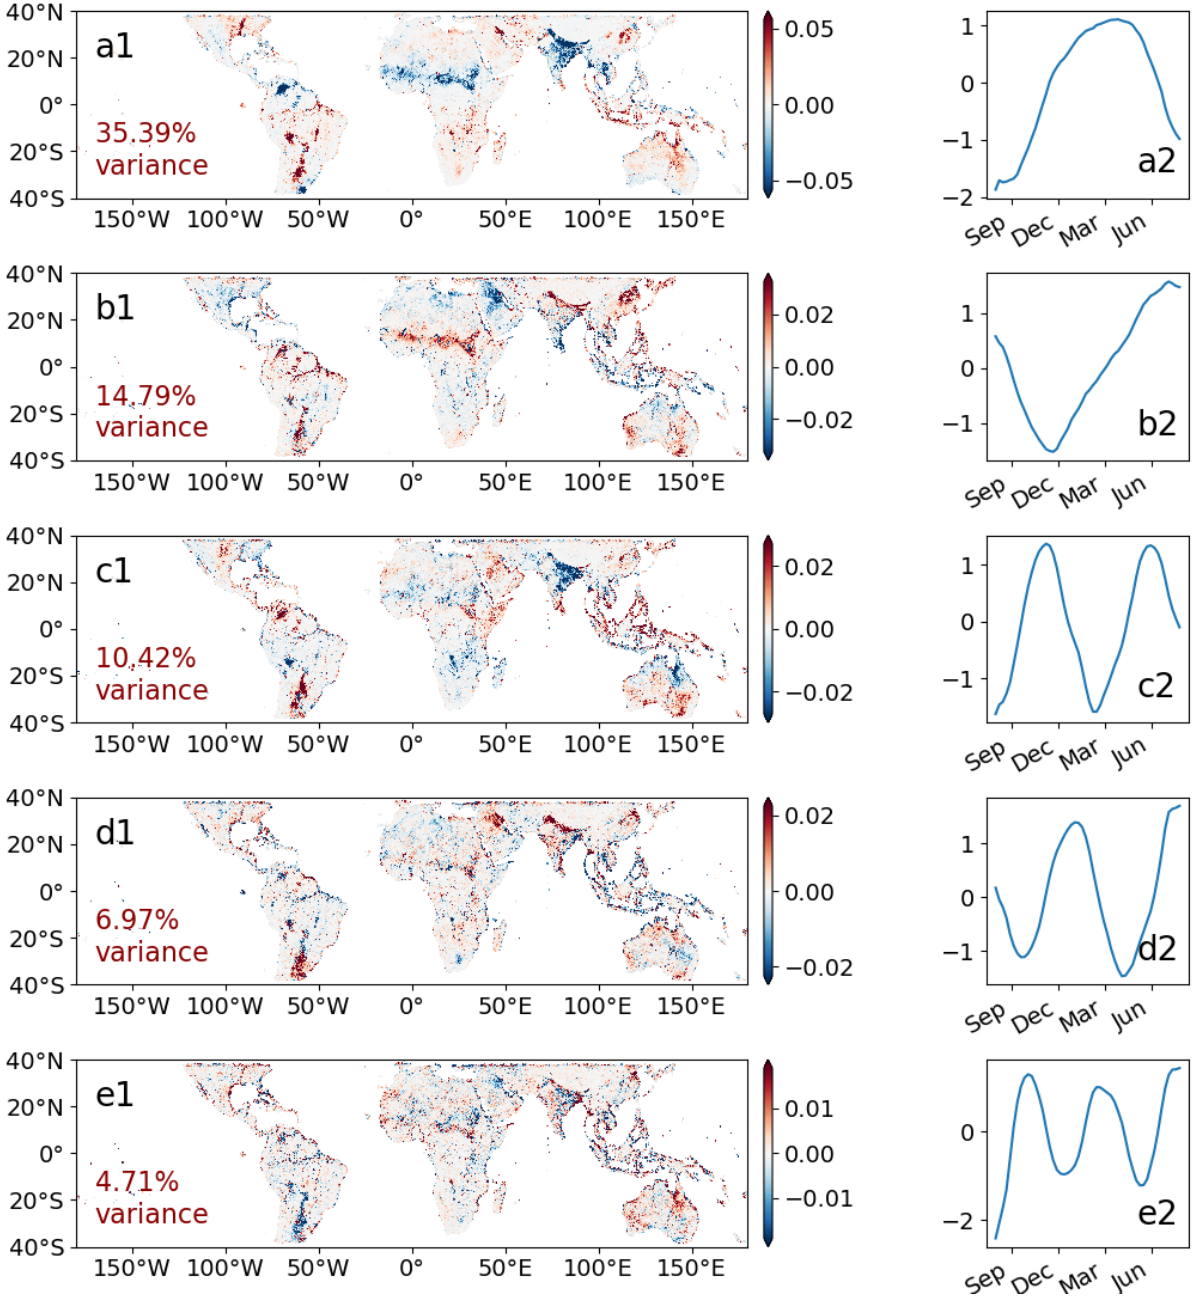
Figure 3. First 5 modes of the Empirical Orthogonal Functions applied to Γ mean . The explained variance ratio for each mode is printed in bottom left corner of the maps. (a1) , (b1) , (c1) , (d1) , (e1) show the map of covariance between Γ mean and the principal components (PC) for modes n°1, 2, 3, 4, 5 respectively. (a2) , (b2) , (c2) , (d2) , (e2) show the time series of the PC for the same